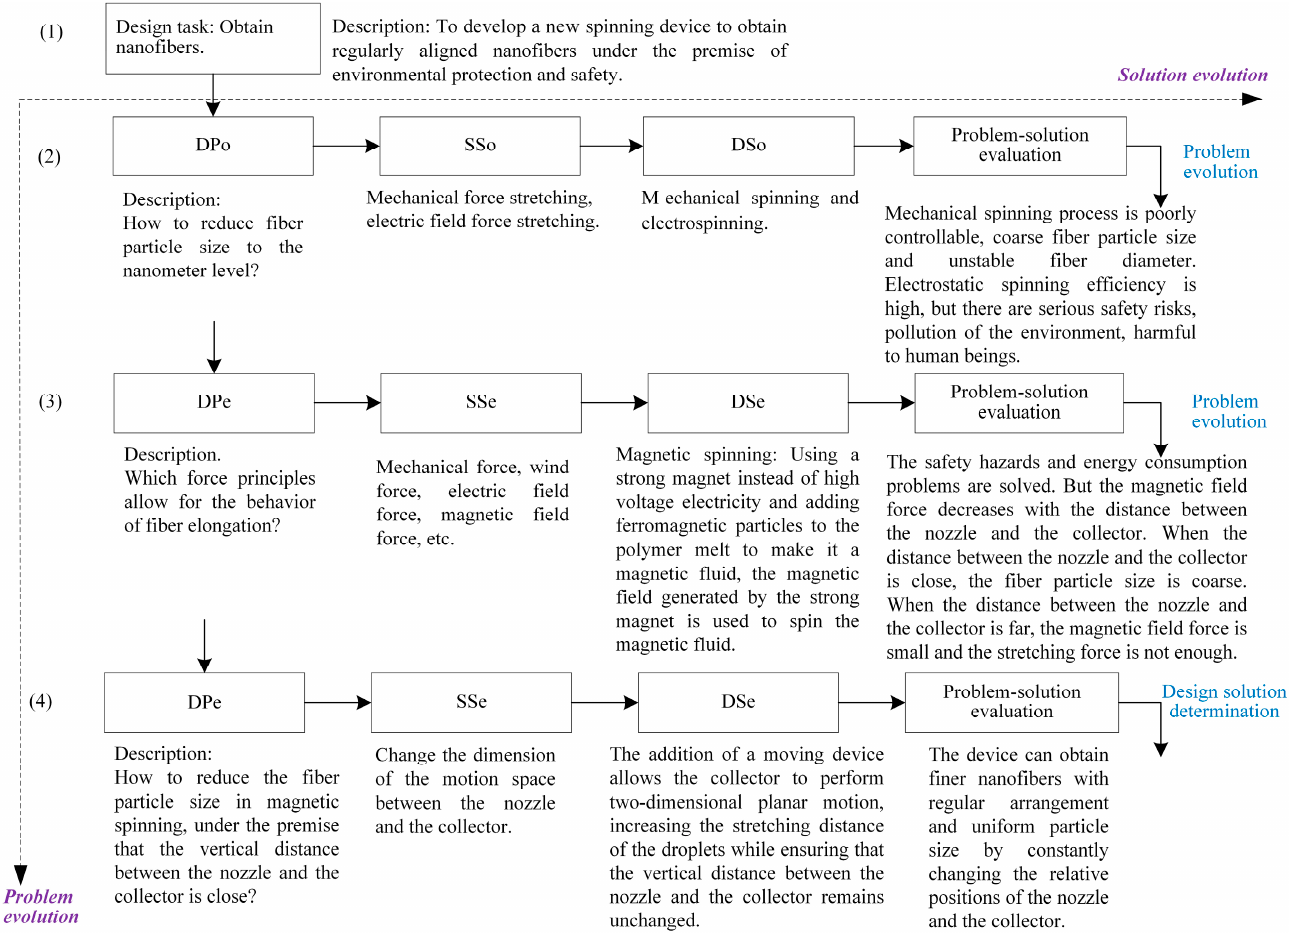
Figure 7. Solution evolution process of the magnetic spinning device.